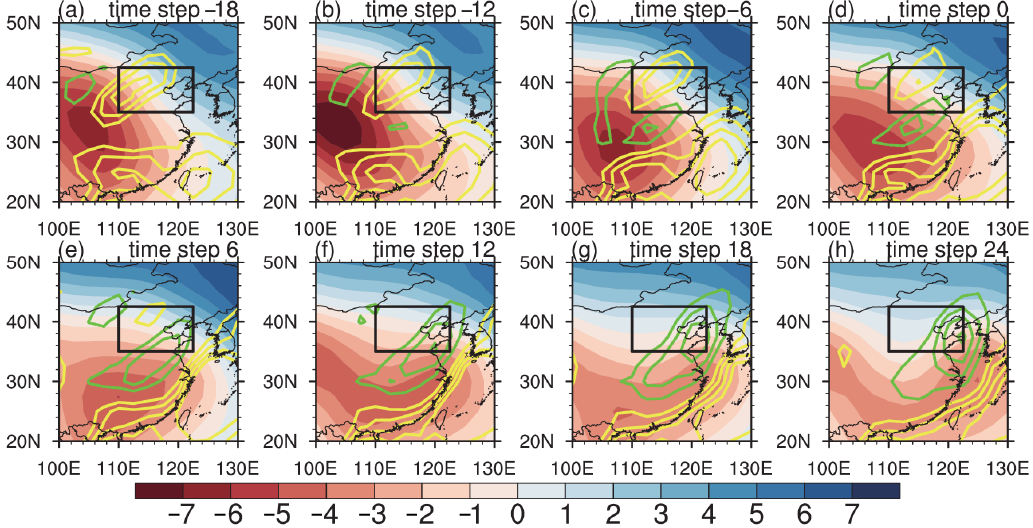
Figure 8. Evolution of SLP anomalies (colors, hPa) and surface meridional wind anomalies (contours, m / s; northerly wind anomalies are in green and southerly wind anomalies are in yellow) with respect to winter climatology at time steps ( a ) –18, ( b ) –12, ( c ) –6, ( d ) 0, ( e ) 6, ( f ) 12, ( g ) 18, and ( h ) 24 for the ISEs in